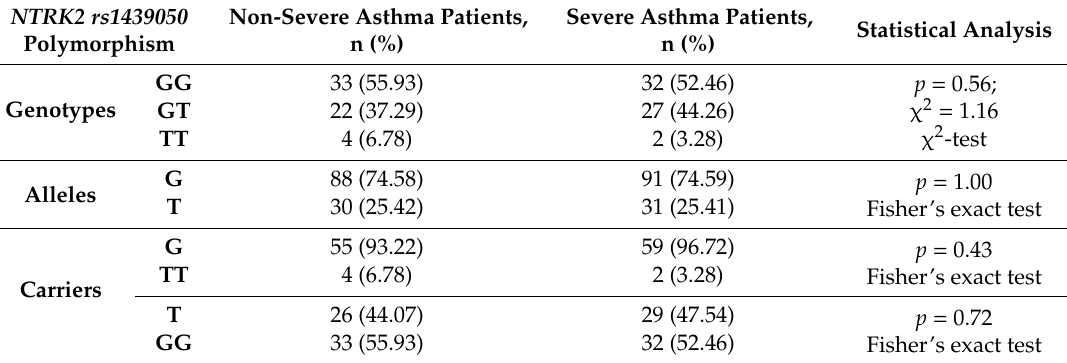
Table 7. Distribution of genotypes, alleles and carriers of NTRK2 rs1439050 polymorphism in non-severe and severe asthma